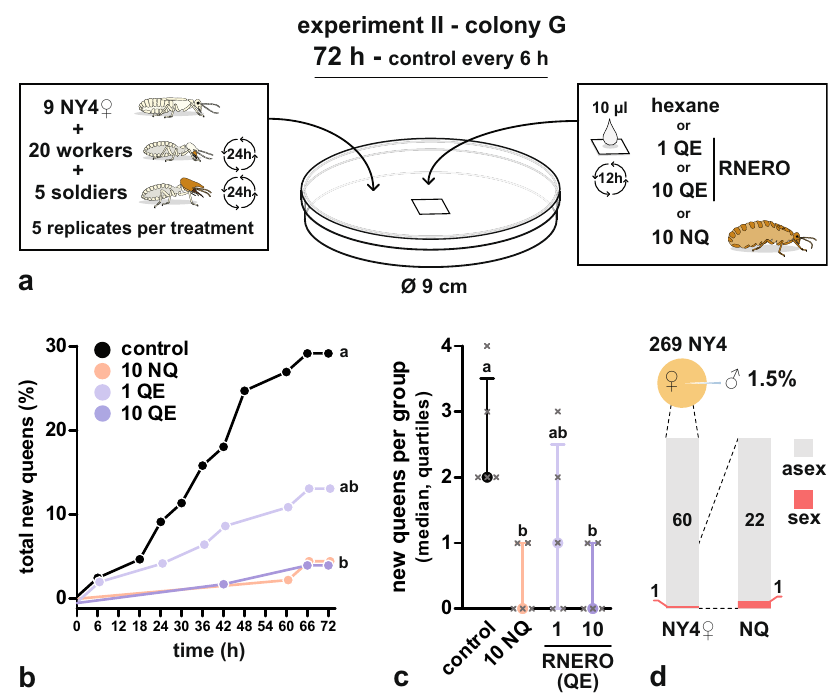
Fig. 4 Presence of mature queens or RNERO inhibits the development of new queens from female nymphs. a Design of queen inhibition experiment with colony G. b Cumulative numbers of new NQs in solvent control and under different treatments. The highly signi fi cant overall difference among all curves (Mantel – Cox test, χ 2 = 17.24, df = 3, p = 6 × 10 − 4 ) was mainly due to signi fi cant differences of 10NQ and 10QE treatments from the control. Different lowercase letters indicate signi fi cant differences at α = 0.05 corrected using Sidak correction for multiple comparisons (pairwise Mantel – Cox test comparisons). c Median numbers (and quartiles) of new NQs per one experimental group, showing signi fi cant overall differences (K – W rank-sum test, H = 10.24, groups = 4, n = 20, p = 1.67 × 10 − 2 ). Different lowercase letters indicate signi fi cant pairwise differences at α = 0.05 in Dunn ’ s Multiple Comparison Test. d Pie chart shows the number of NY4 found in the colony (pie size) and the proportion of males among NY4. Left column shows the proportion of sexually (sex) and parthenogenetically (asex) produced NY4 ♀ in the genotyped subset of females that entered the experiment. Right column shows the proportion of sexually and parthenogenetically produced NQs that developed in the